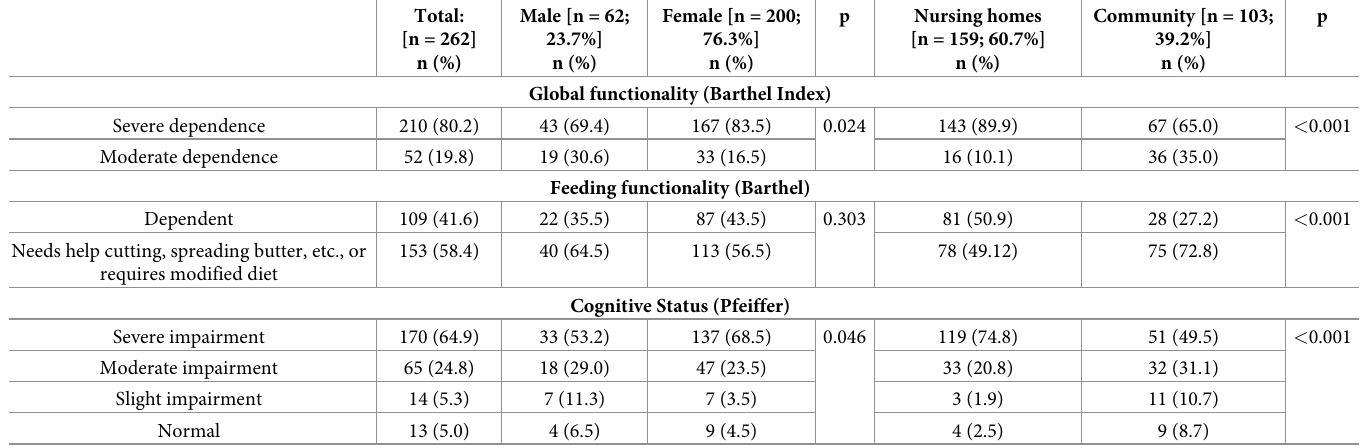
Table 1. Functional status of